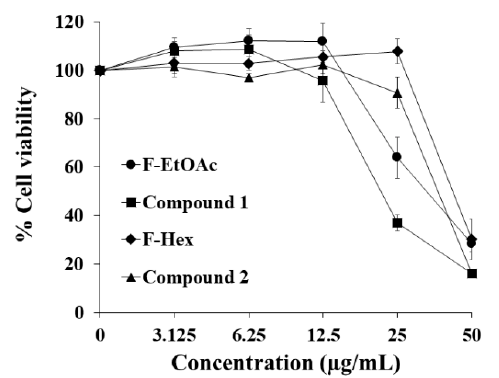
Figure 4. Cytotoxicity of crude fractional extracts and pure compounds from C. comosa to peripheral blood mononuclear cells (PBMCs). PBMCs were treated with ethyl acetate fraction (F-EtOAc), compound 1 , hexane fraction (F-Hex), and compound 2 for 48 h. The MTT assay determined the cell viability. Each point represents the mean ± SE of five independent experiments performed in triplicate.